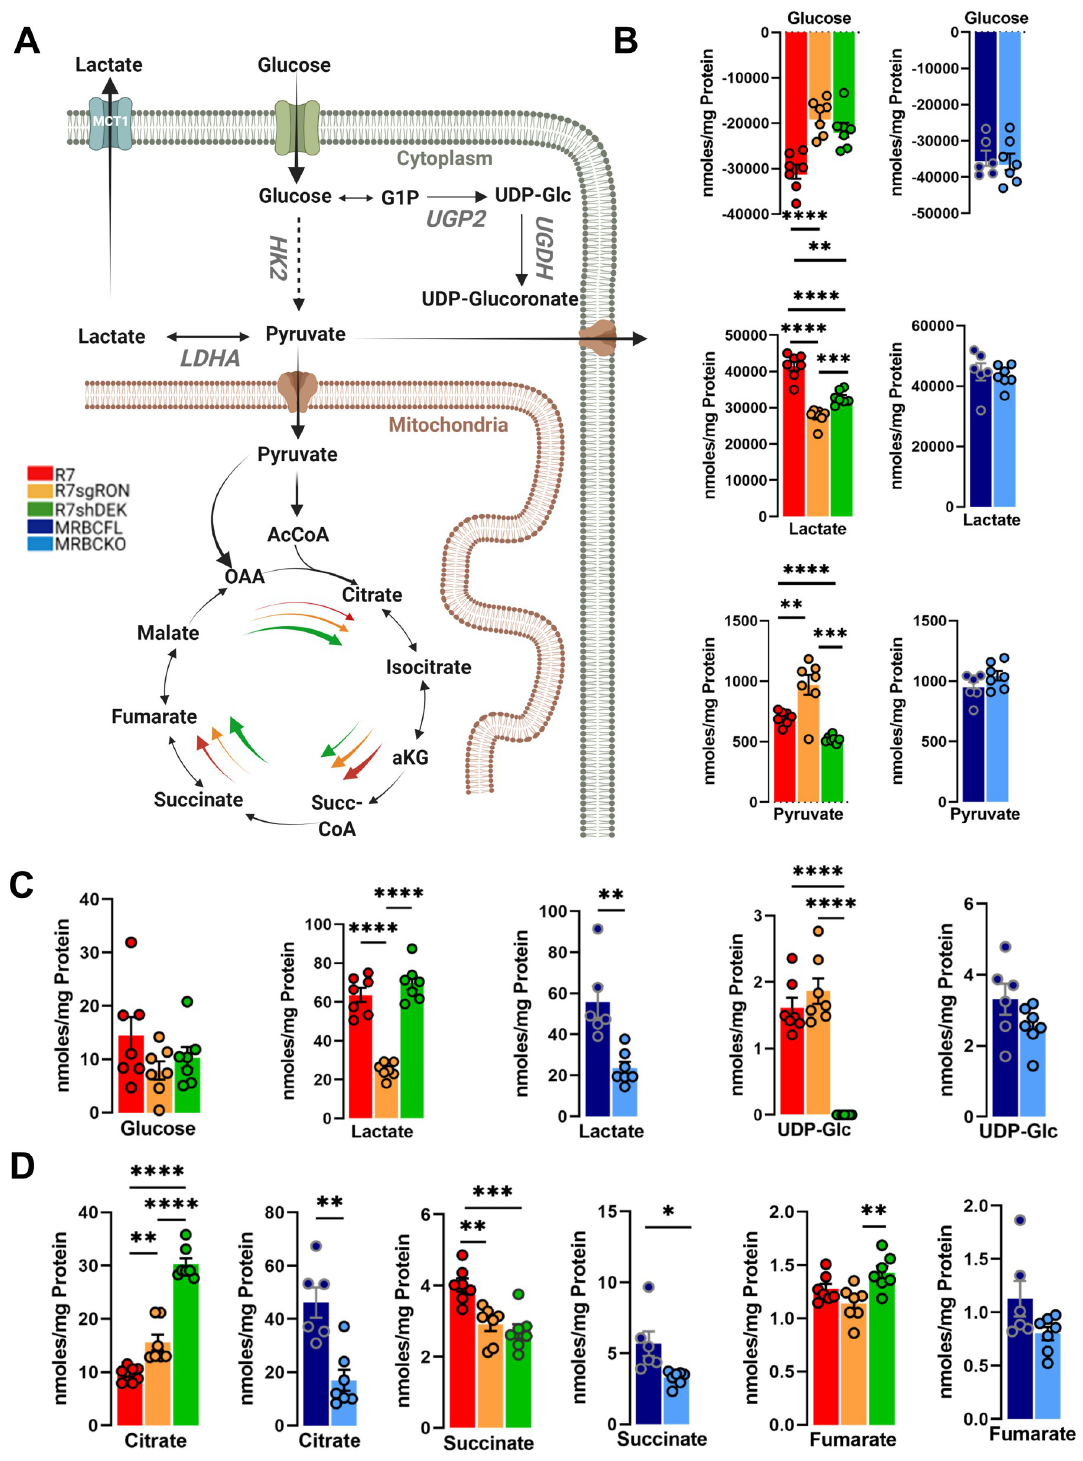
Fig 1. Glycolysis and TCA cycle modulation by the RON-DEK- β -catenin axis. ( A ) Schematic of glycolysis and TCA cycle pathway (created with BioRender.com) illustrating the trends of R7 (red), R7sgRON (orange), R7shDEK (green), MRBC FL (dark blue), and MRBC KO cell lines (light blue). ( B ) Extracellular glycolysis-derived metabolites imported or released by the cells into the culture media quantified from 1 H-NMR spectra and normalized to the protein content after 24 h of cell incubation. The amount of metabolites consumed or produced were calculated as ( Δ metabolite = n (metabolite)t24h –n (metabolite)t0h; n (moles of metabolites